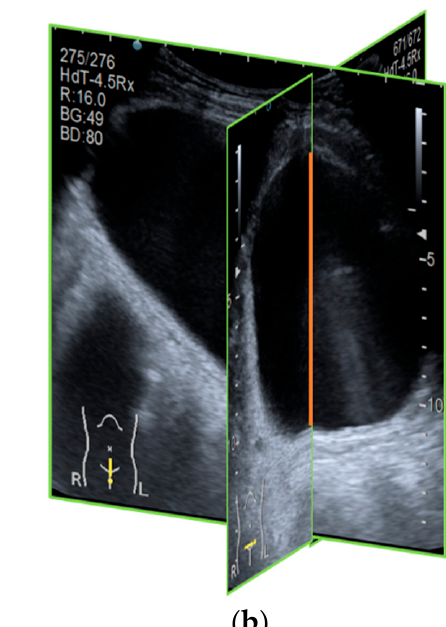
Figure 3. ( a ) Original 2D ultrasonic image. ( b ) The transverse view and sagittal view are aligned (crossover) in the maximum vertical line.